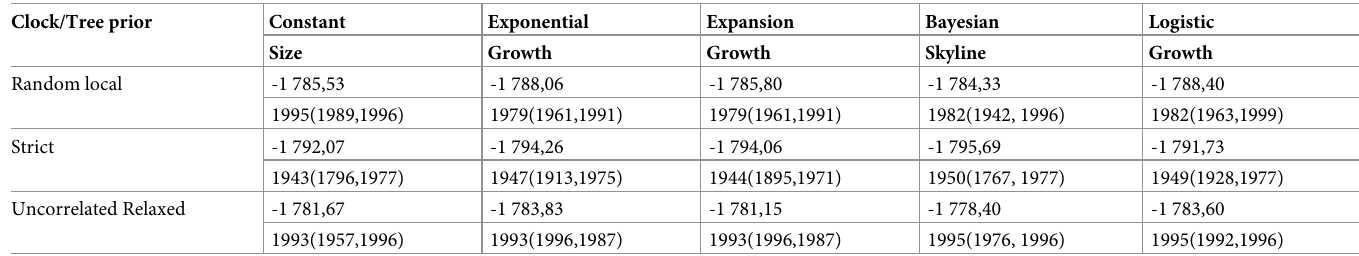
Table 3. Fitting models bayes factors and HPD95% related to RV-C45. Clock/Tree